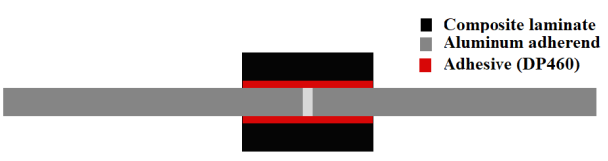
Figure 19. Double strapped composite joint as studied by Akpinar [138].